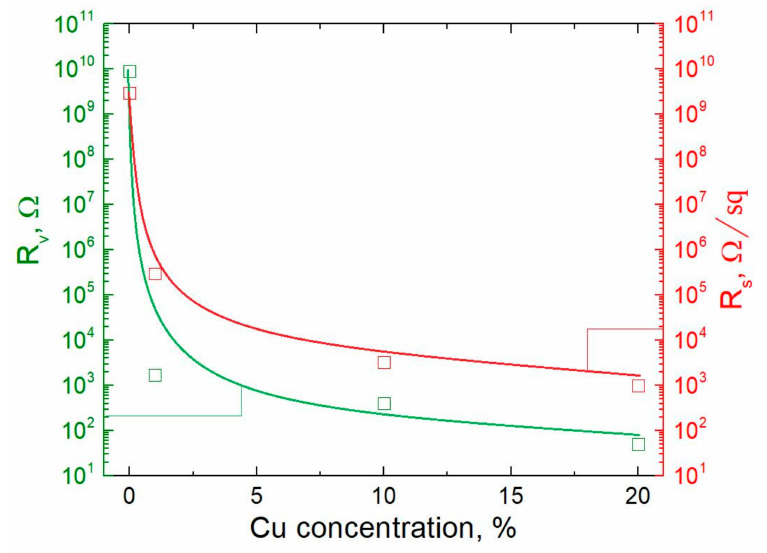
Figure 7. Dependences of the volume and surface resistance on the proportion of copper content in the